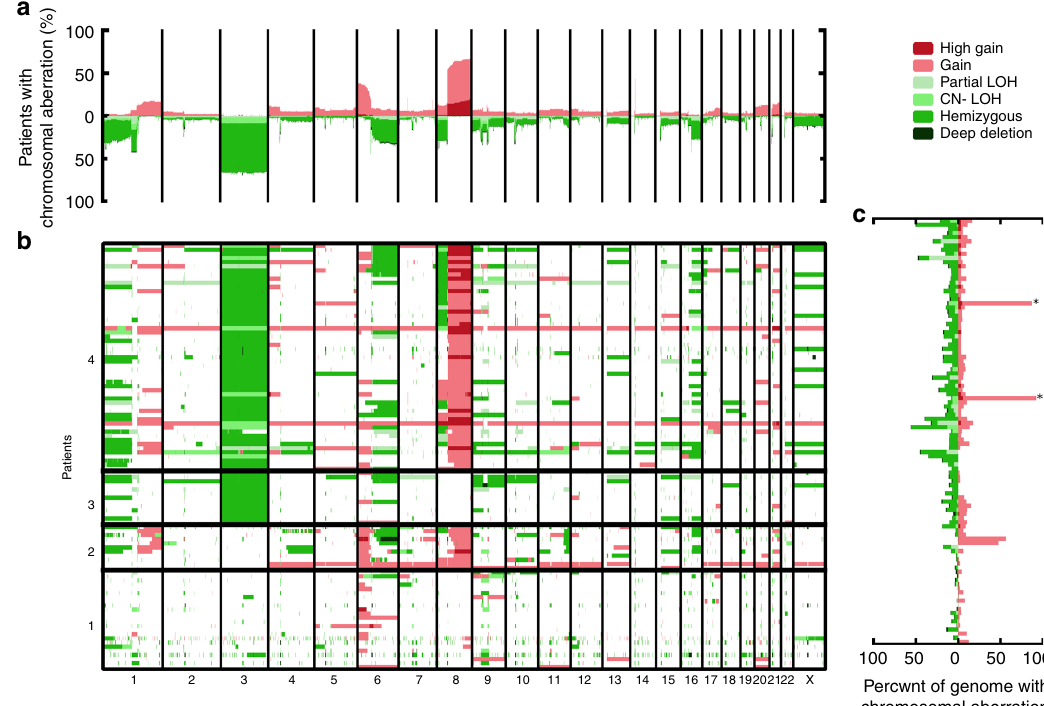
Fig. 2 Copy number gains and losses in uveal melanoma. Samples are arranged according to their category de fi ned by status of chromosome arms 3p and 8q. a Total number gains/losses in each genomic region. b Gains (red) and losses (green) shown in each sample and region. c The fraction of the genome having aberrations in each sample. * Sample with whole-genome duplication. Source data are provided as a Source data fi